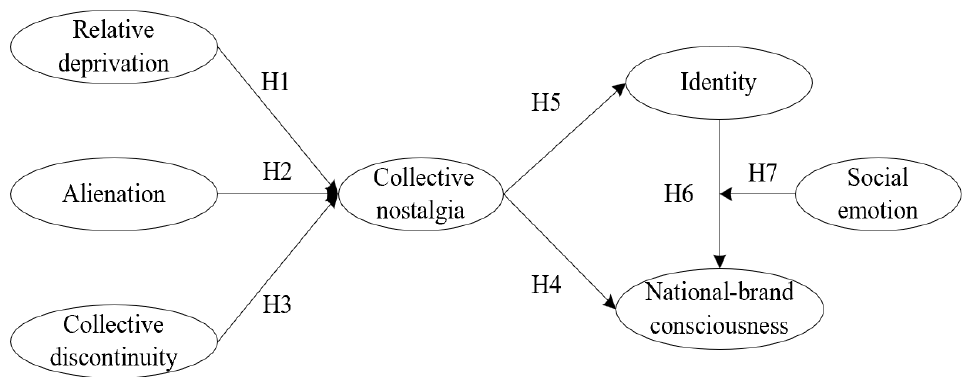
Figure 1. The conceptual